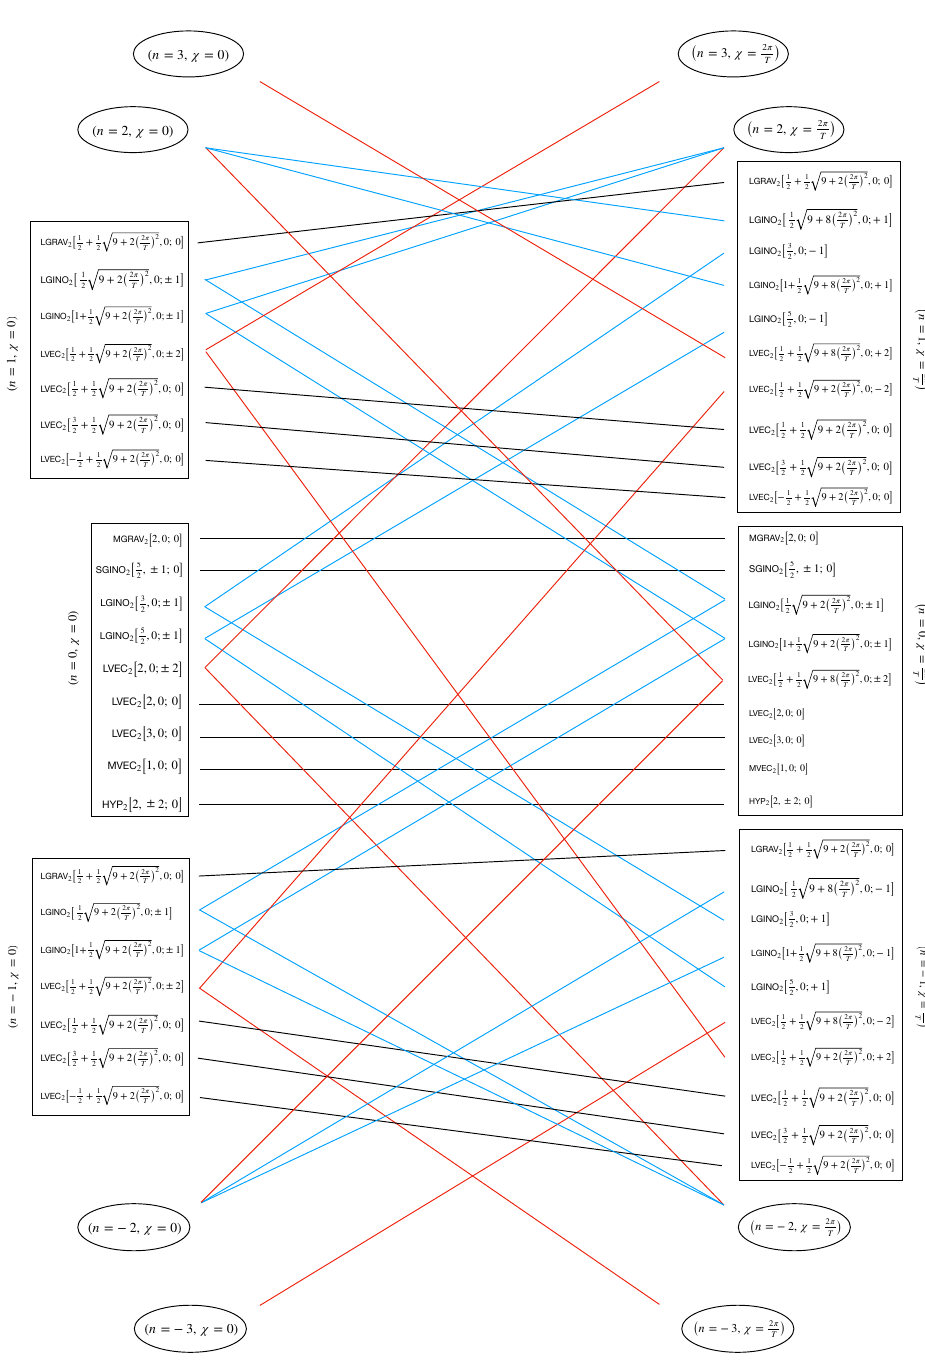
Figure 2 . ‘Space invasion’ patterns for the reassembling of the OSp (4 | 2) × U (1) F multiplets present in the KK spectrum on Family III, (2.13), within the CM at KK levels ‘ = 0 , n = 0 , ± 1 , ± 2 , . . . , into OSp (4 | 4) multiplets at the same S 5 level ‘ = 0 but possibly different S 1 level n , at χ = 0 (left) and χ = 2 π/T (right). The boxes correspond to the multiplet content in (3.15) with ‘ 1 = ‘ 2 = 0 and n fixed as indicated. Black lines connect χ -independent, flavour-neutral N = 2 multiplets. Blue and red lines respectively connect N = 2 multiplets that need to be retrieved from one or two higher (or lower) S 1 KK